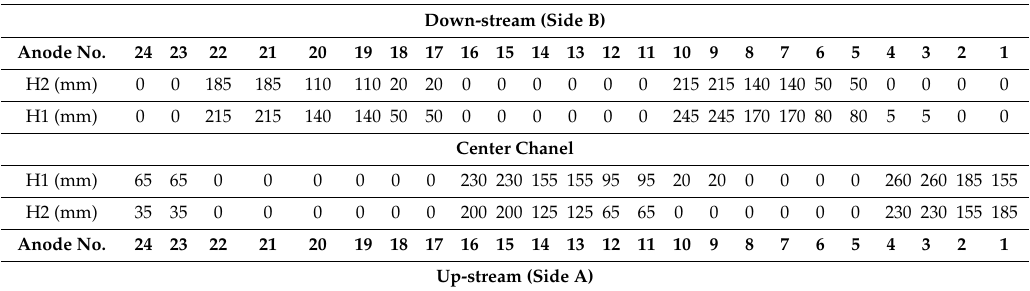
Table 1. Detailed slot configurations and parameters at a critical instant of real cell